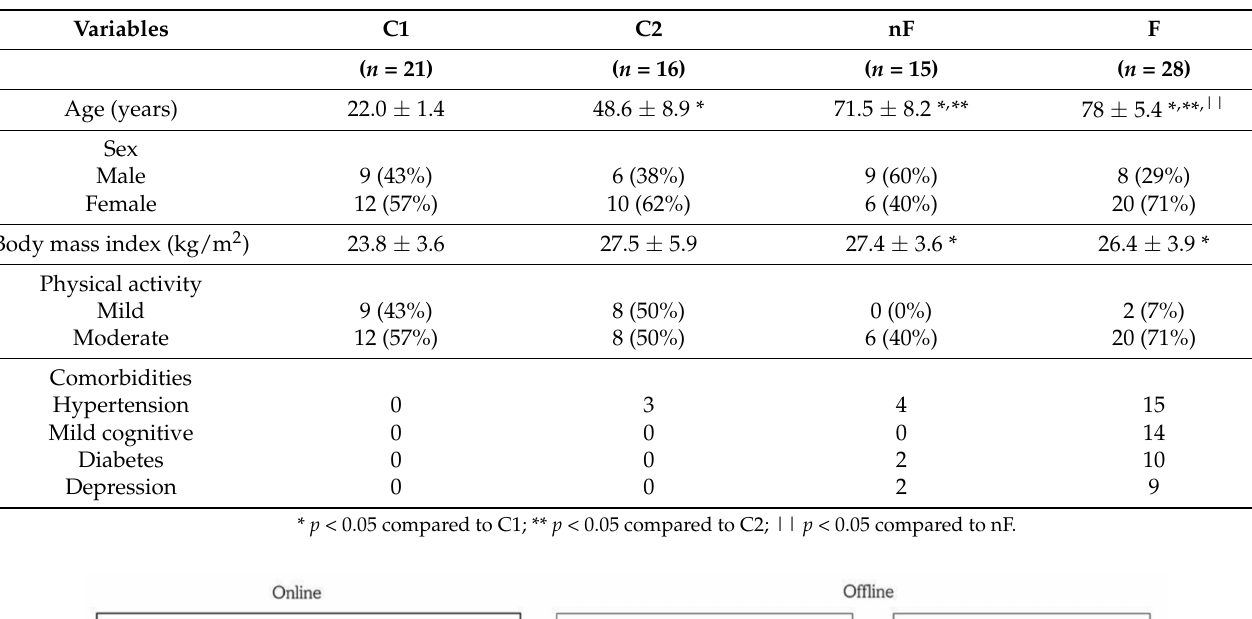
Table 1. Demographic and most common comorbidities of the study participants. Results are reported as mean ± standard deviation or absolute value (percentage).